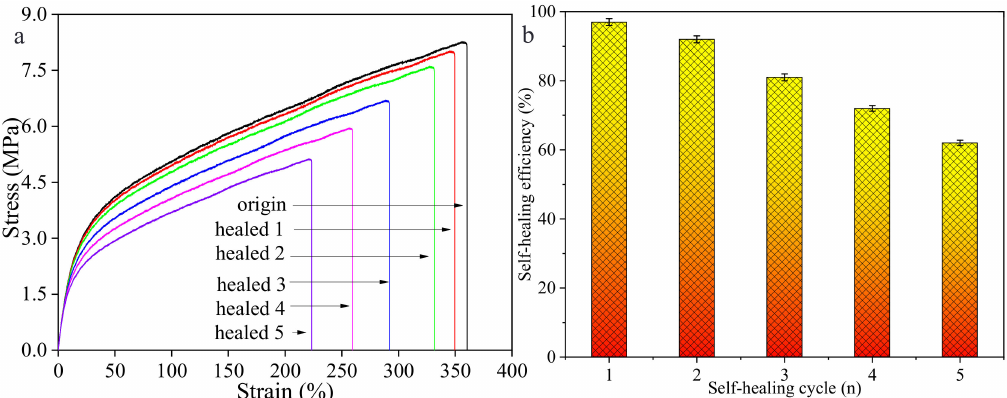
Figure 15. ( a ) Stress–strain curves of the composite film and ( b ) the self-healing efficiencies after five